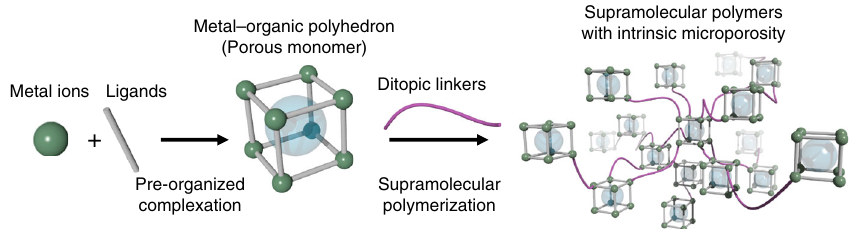
Fig. 1 Supramolecular polymerization of porous monomers. Schematic illustration of the synthesis of MOPs as porous monomers and their subsequent coordination-driven self-assembly. Ditopic linkers are used to link the MOPs together to form supramolecular polymers with intrinsic porosity arising from the MOP units